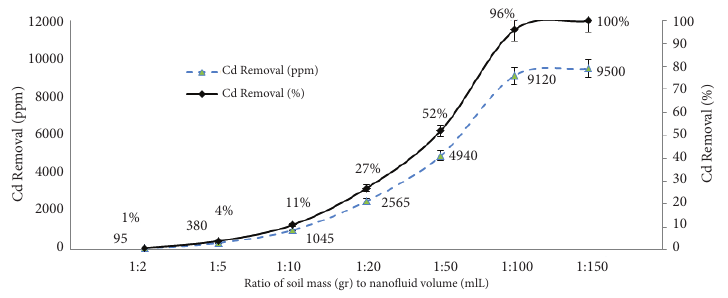
Figure 7. Removal of Cd by nanofluid with different Ratio of soil mass (gr) to volume of nanofluid (mL) (Concentration = 500 ppm, pH = 6.5, Contact time = 24